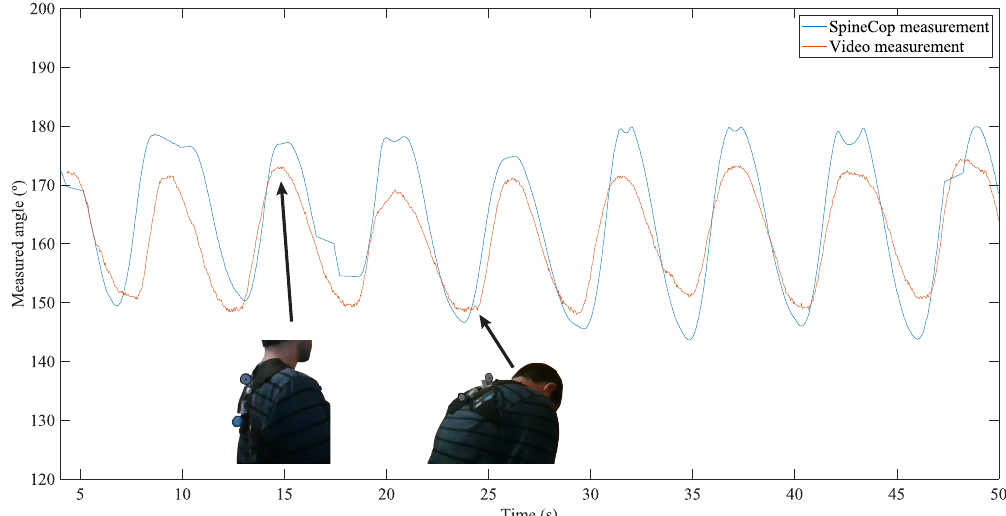
Figure 7. Angles measured by the SensorTile (blue line) and the video analysis (orange line). The positions performed by the user are shown in the